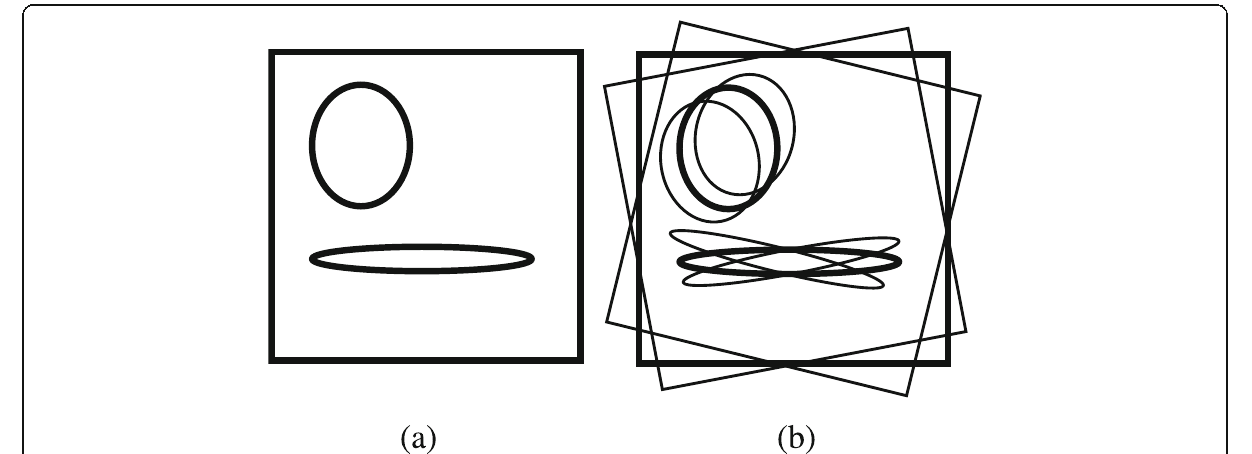
Fig. 1 Outline diagrams for images reconstructed from a the original under-sampled sinogram and b linearly interpolated